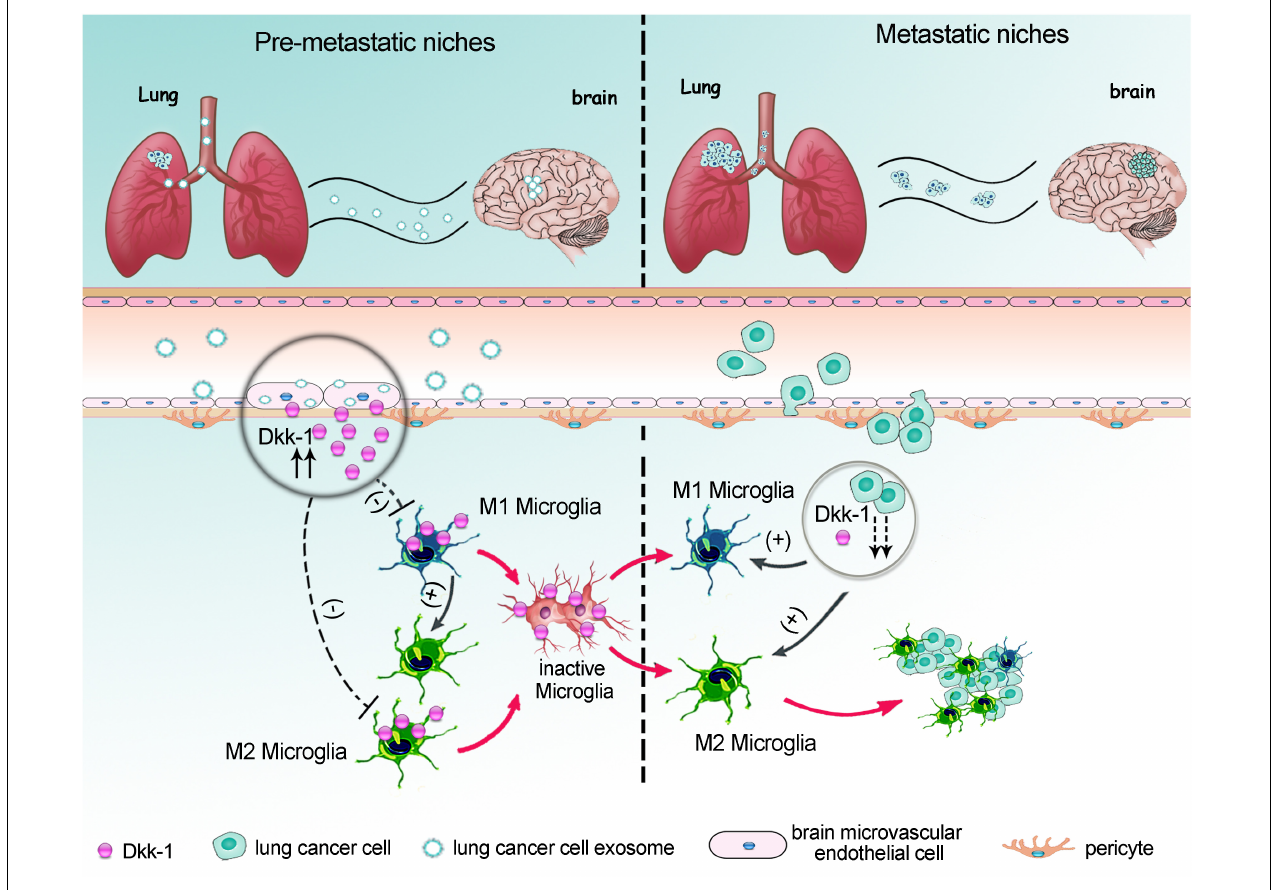
FIGURE 7 | A proposed model for lung cancer cells-controlled Dkk-1 production in brain metastatic cascades driving microglia to acquire a pro-tumorigenic phenotype. As a major component of BBB, the brain microvascular endothelia cells were the primary target for lung cancer-derived exosomes. The incipient exosomes induced the release of Dkk-1 from brain endothelial cells. The Dkk-1 inside brain might directly hold microglia in an inactive state; meanwhile indirectly drive the existed M1-like microglia to convert into the pro-tumorigenic M2-like microglia. An absolutely less M1 polarized microglia and a relatively more M2 polarized microglia caused the deficits of immune response during the initial phase of pre-metastatic niche formation. When the metastatic lung cancer cells emerged into brain, the decline of Dkk-1 in metastatic lung cancer cells would facilitate microglia to acquire tumor-supportive phenotype and massively infiltration into metastatic